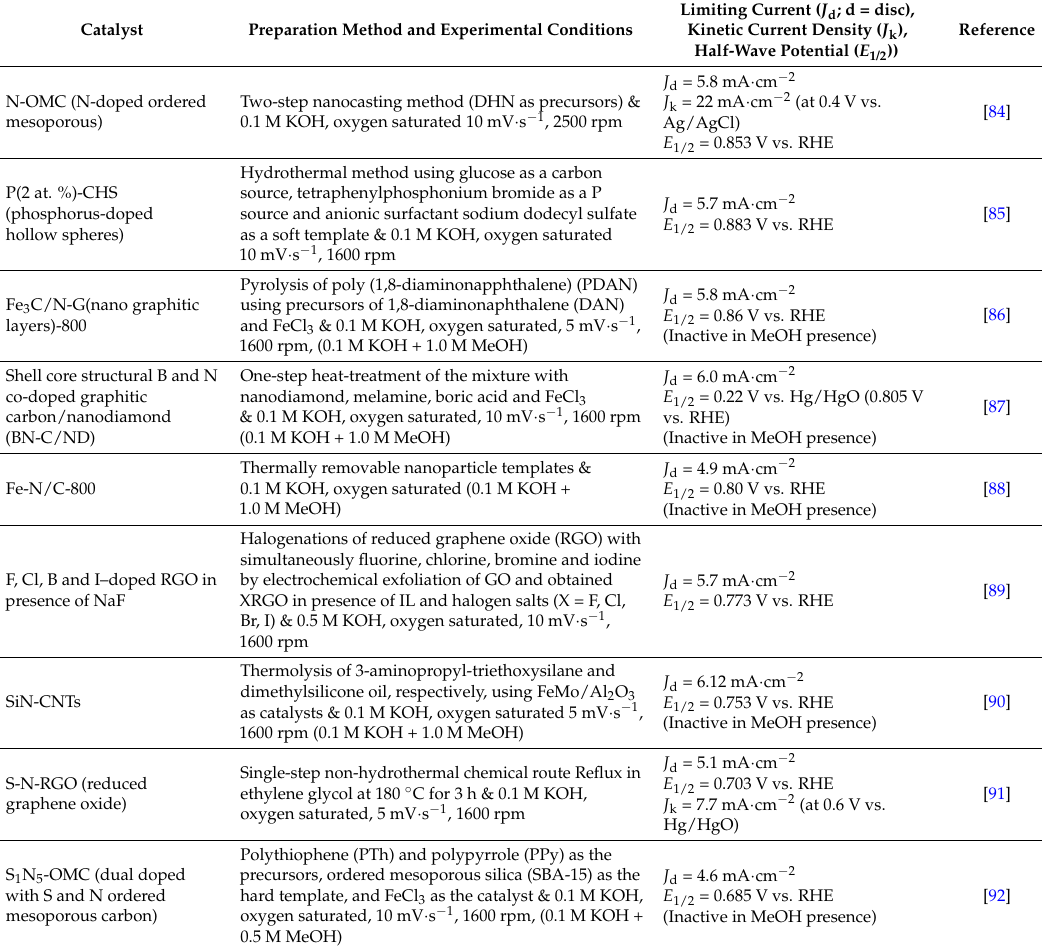
Table 4. Non-precious dual-doped carbon ORR